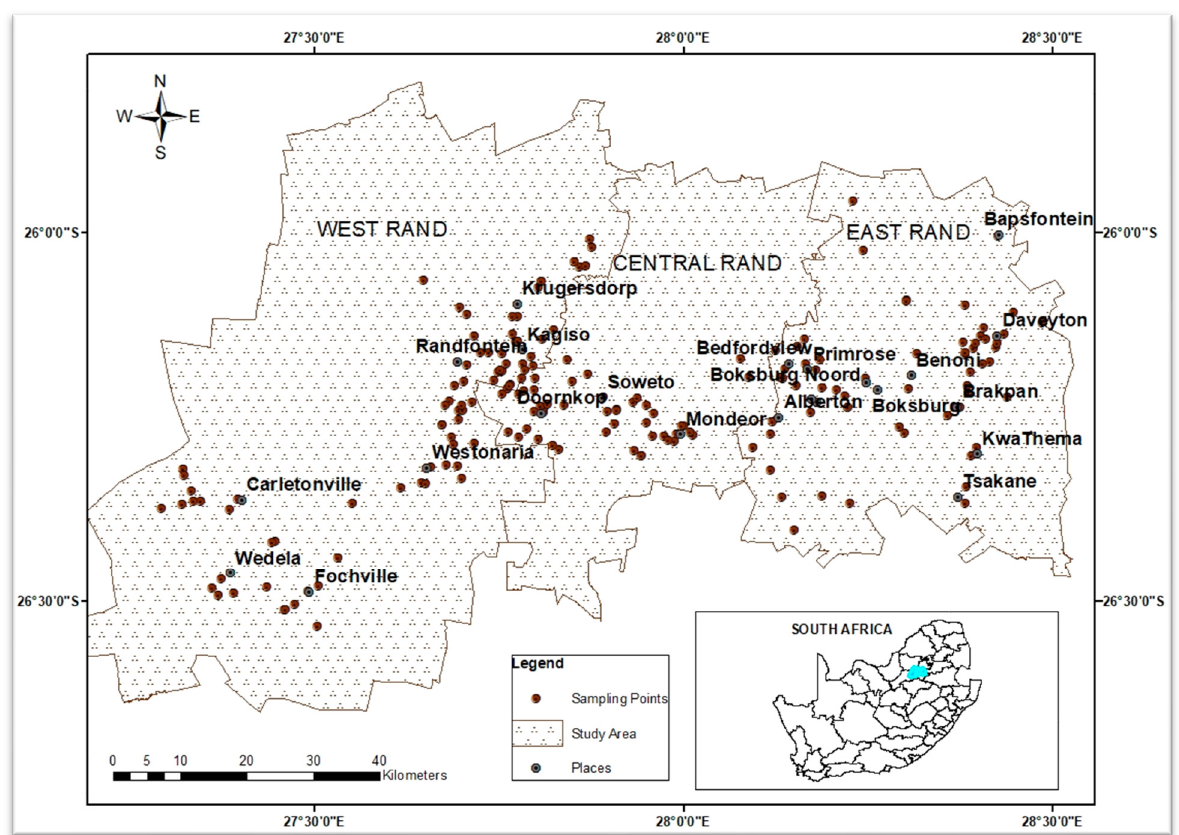
Figure 1. Study area map showing the studied areas and points where measurements were taken. Geologically, the area is composed of basement crystalline rocks, metasedimentary, and meta-volcanic rocks (Figure 2). The basement rocks are represented by the Archean (3.34 Ga) greenstone rocks that make up the Johannesburg Dome with prominent intrusions of tonalities, granodiorites, granites, gabbro, and migmatites [12–14]. The metasedimen- tary rocks that include the shale and quartzites of the Witwatersrand Supergroup were deposited between 3074 and 2714 Ma [15]. These rocks belong to the West Rand Group and the Central Rand Group of the Witwatersrand Supergroup. There are also quartz- pebbles conglomerates, which host the majority of the gold mineralization in the area [16]. The area is also underlain by the andesites of the Klipriviersberg Group of the Ventersdorp Supergroup, which were deposited between 2714 and 2665 Ma [17]. The rocks of the Ventersdorp Supergroup are overlain by the Transvaal Supergroup, which is Neo-Archaean to Palaeo-Proterozoic in age [18]. The Transvaal Supergroup rocks are mostly exposed in the south-eastern portion of the study area (Figure 2) and the dominant rock types include the quartzites of the Black Reef Formation, dolomites and iron formations of Chuniespoort Group as well as the Pretoria Group shale alternating with quartzitic sandstones [11,18,19]. The Karoo Supergroup, which overlies the Transvaal Supergroup, is mostly exposed in the eastern part of the area (Figure 2) and the dominant rock types include the mudrocks and sandstone of the Ecca Group [20].